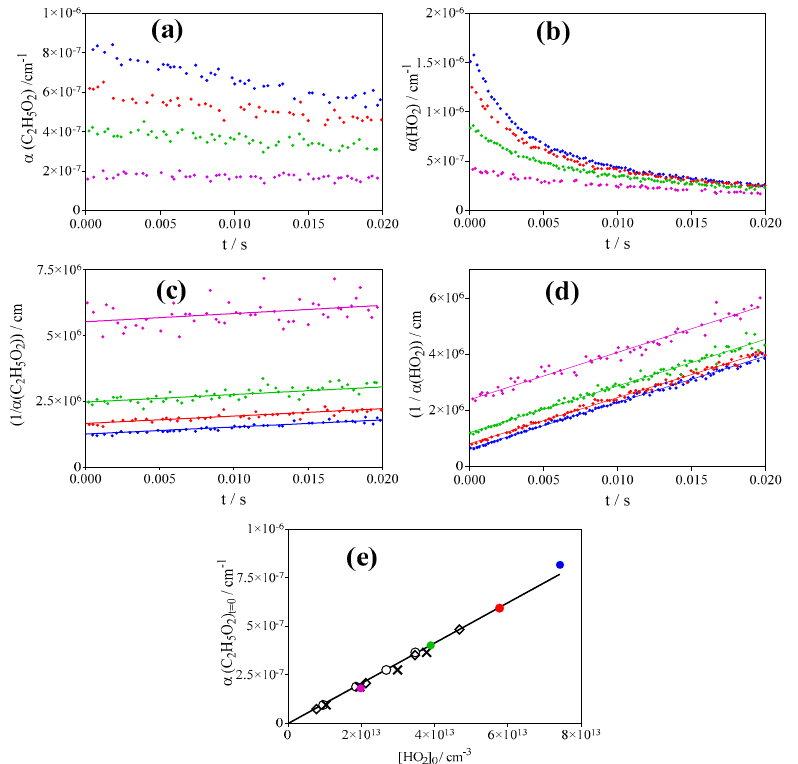
Figure 3. Example of measurement of the C 2 H 5 O 2 absorption cross-section relative to the HO 2 absorption cross-section. Upper graphs: C 2 H 5 O 2 ( a ) and HO 2 ( b ) absorption time profiles. Graphs ( c ) and ( d ): same profiles, converted to 1/ α (see Equation (3)) and linear regression over the first 20 ms following the photolysis pulse. Lower graph ( e ) shows plot of α (C 2 H 5 O 2 ) t=0 ms = f ([HO 2 ] t=0 ms ): open circles and open diamonds are obtained using HO 2 measurements at 6638.2 cm − 1 , coloured points (from above graphs) and crosses are obtained using HO 2 measurements at 6638.58 cm − 1 . [O 2 ] = 2.8 × 10 18 cm − 3 , [C 2 H 6 ] = 3.7 × 10 16 cm − 3 for all